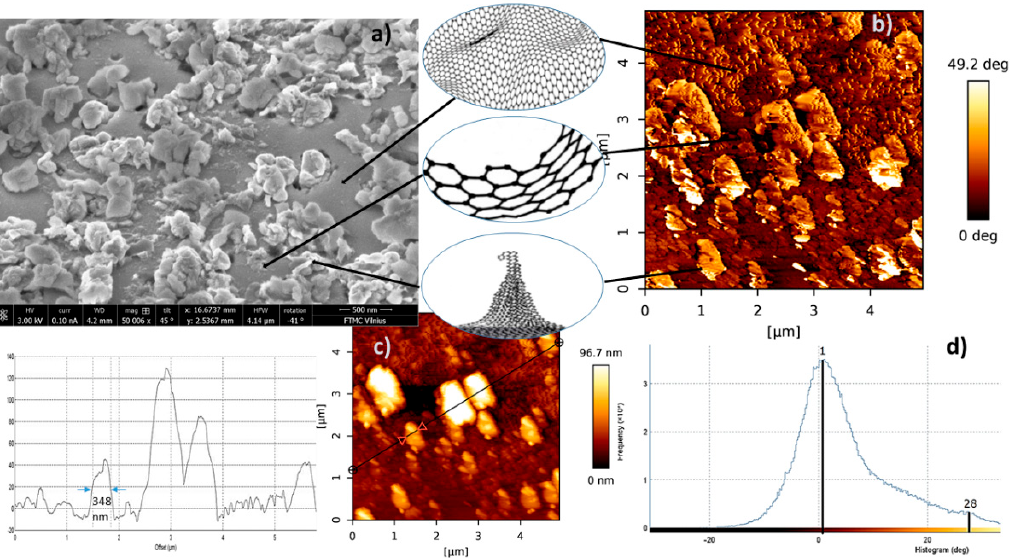
Figure 9. Microscopic analysis of the surface of the graphene layer grown in a single-step process (measured after etching of the Co film): ( a ) SEM image, ( b ) AFM phase imaging, ( c ) AFM 2D image and profilogram, ( d ) AFM phase imaging histogram. The thickness of the Co layer was 25 nm, synthesis temperature 700 °C, ion beam energy 800 eV, ion beam treatment time—15 min.